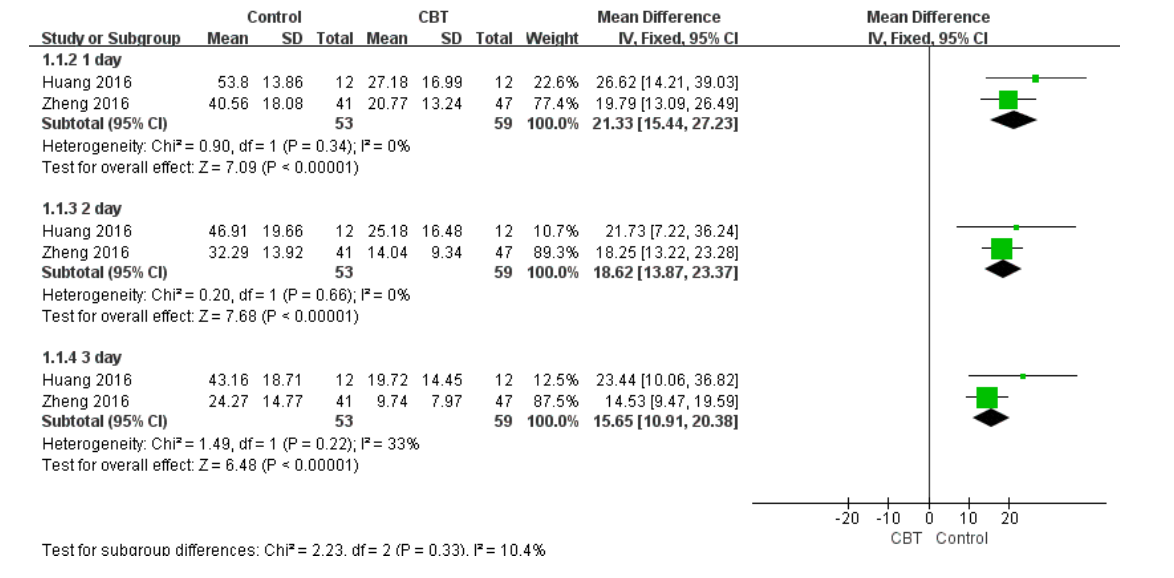
mean difference (95% confidence interval), show evidence favouring music therapy for pain